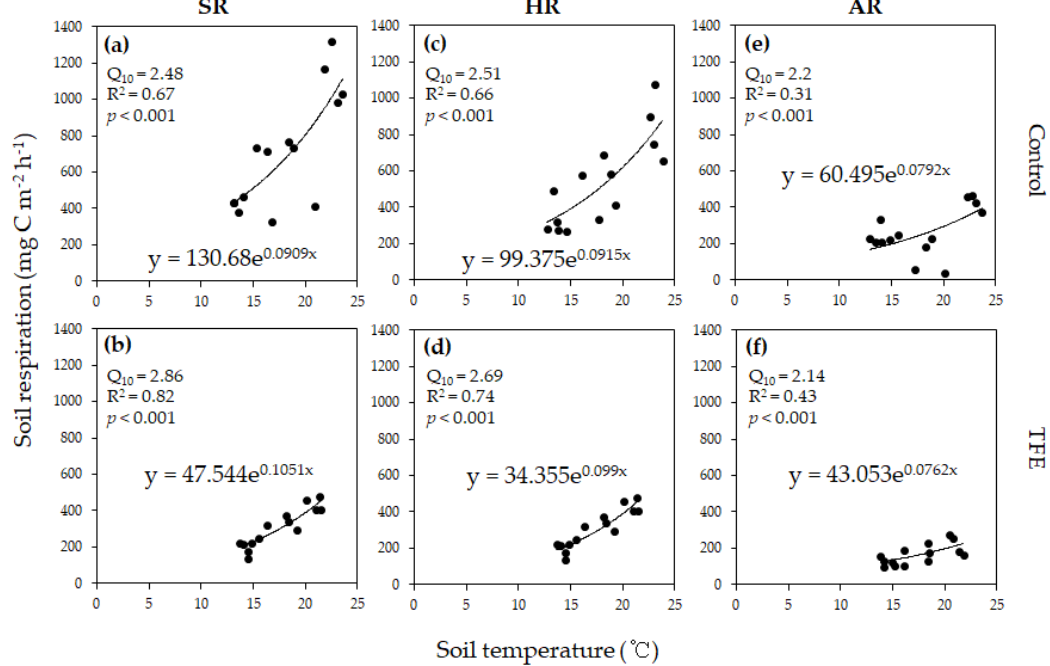
Figure 5. Soil temperature dependency of ( a , b ) total soil respiration (SR), ( c , d ) heterotrophic soil respiration (HR), ( e , f ) autotrophic soil respiration (AR) in control and throughfall exclusion (TFE) plots. Exponential function is 𝑦 = 𝛽 0 × exp(𝛽 1 ∙ 𝑥) ; y is measured soil respiration ( R S ), x is soil temperature and 𝛽 0 and 𝛽 1 are fitted parameters. Q 10 function is 𝑄 10 = exp (10 ∙ 𝛽 1 ) . R 2 is coefficient of determination and p represents p -value.